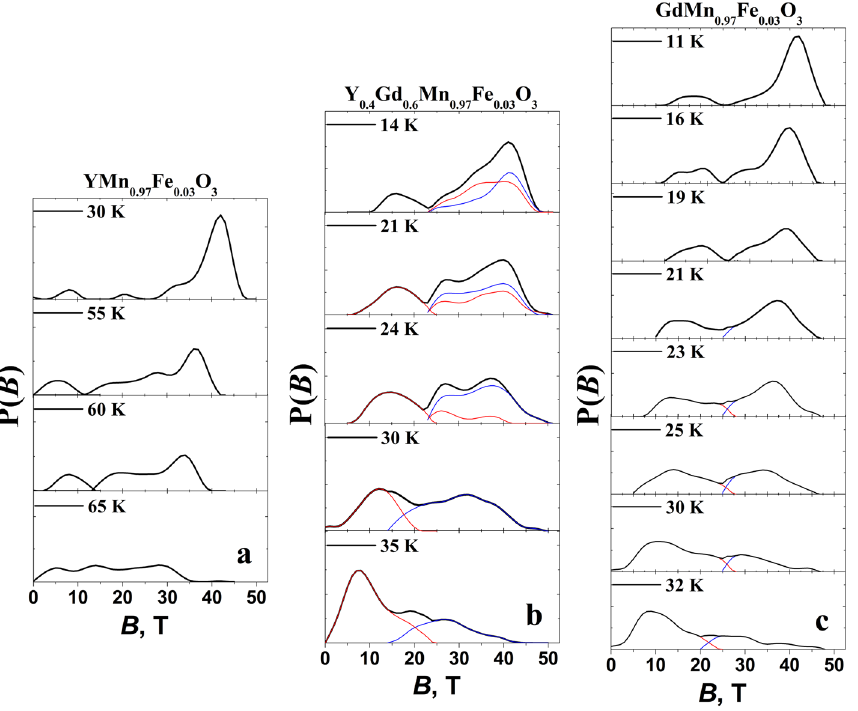
Figure 10. Hyperfine field distributions P( B ) of YMn 0.97 Fe 0.03 O 3 ( a ), Y 0.4 Gd 0.6 Mn 0.97 Fe 0.03 O 3 ( b ), and